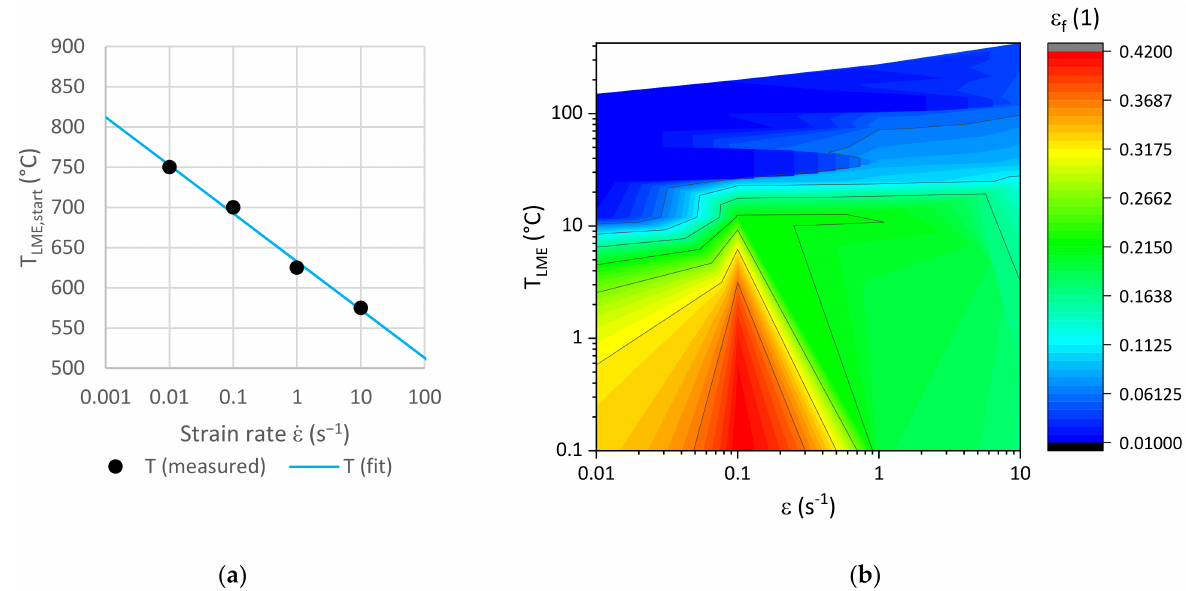
Figure 6. ( a ) Minimum temperature for LME depending on the strain rate and ( b ) fracture strain of the virtual to 0 ◦ C shifted LME starting temperature.